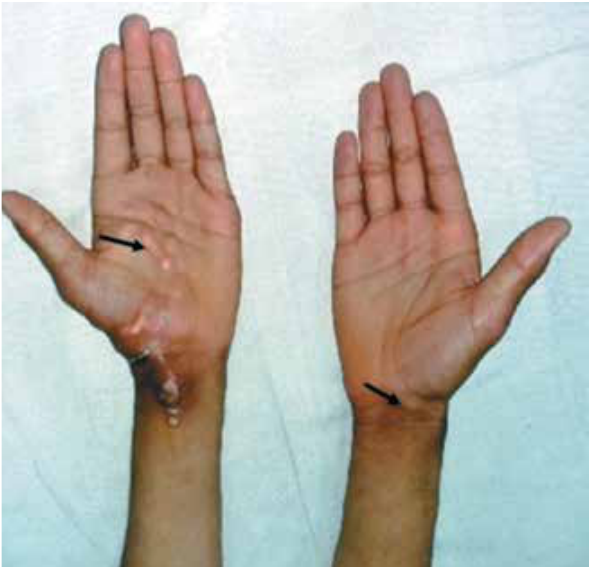
Fig 1. Calcinosis cutis over both palms and flexor aspect of left wrist